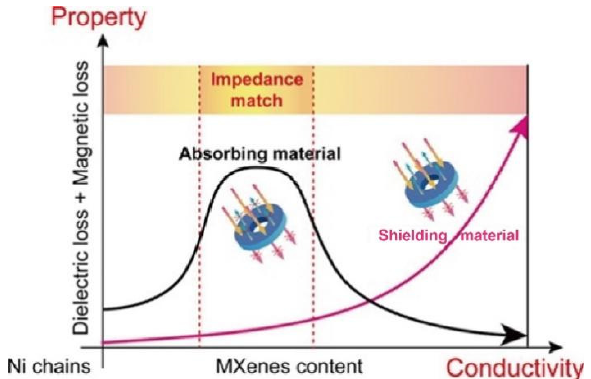
Figure 3. Relationship between impedance match and conductivity for the design of EM shielding and absorption materials.